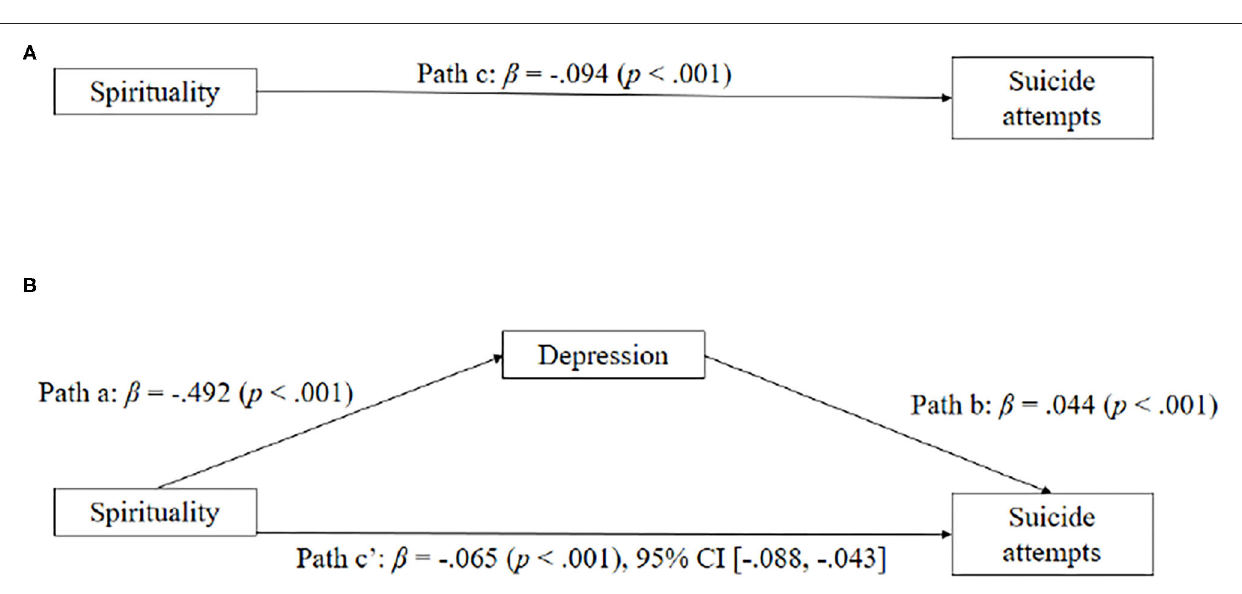
= − 0.492, SE = 0.740, p < 0.001). The association